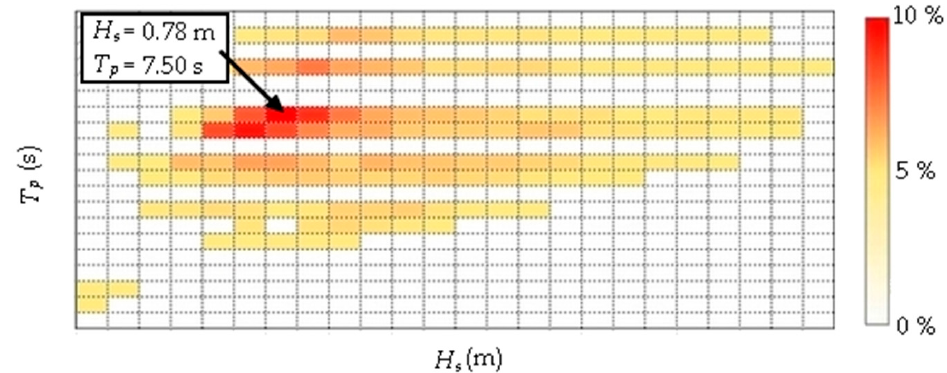
Figure 3. Histogram of frequency of occurrence of sea state for the point referring to SVP.